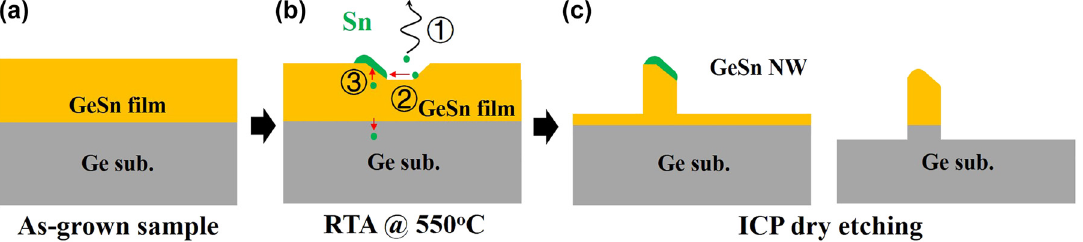
Figure 3: Structure diagram of the sample after each process for fabrication of self-assembled GeSn vertical NWs: (a) as grown sample; (b) annealed sample; (c) NW